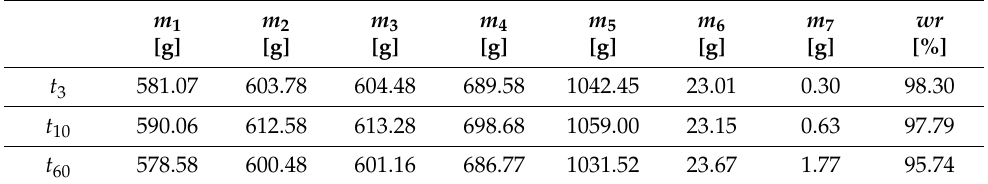
Table 6. Results of the water retention test performed on one mortar specimen reinforced with RM2 dispersed